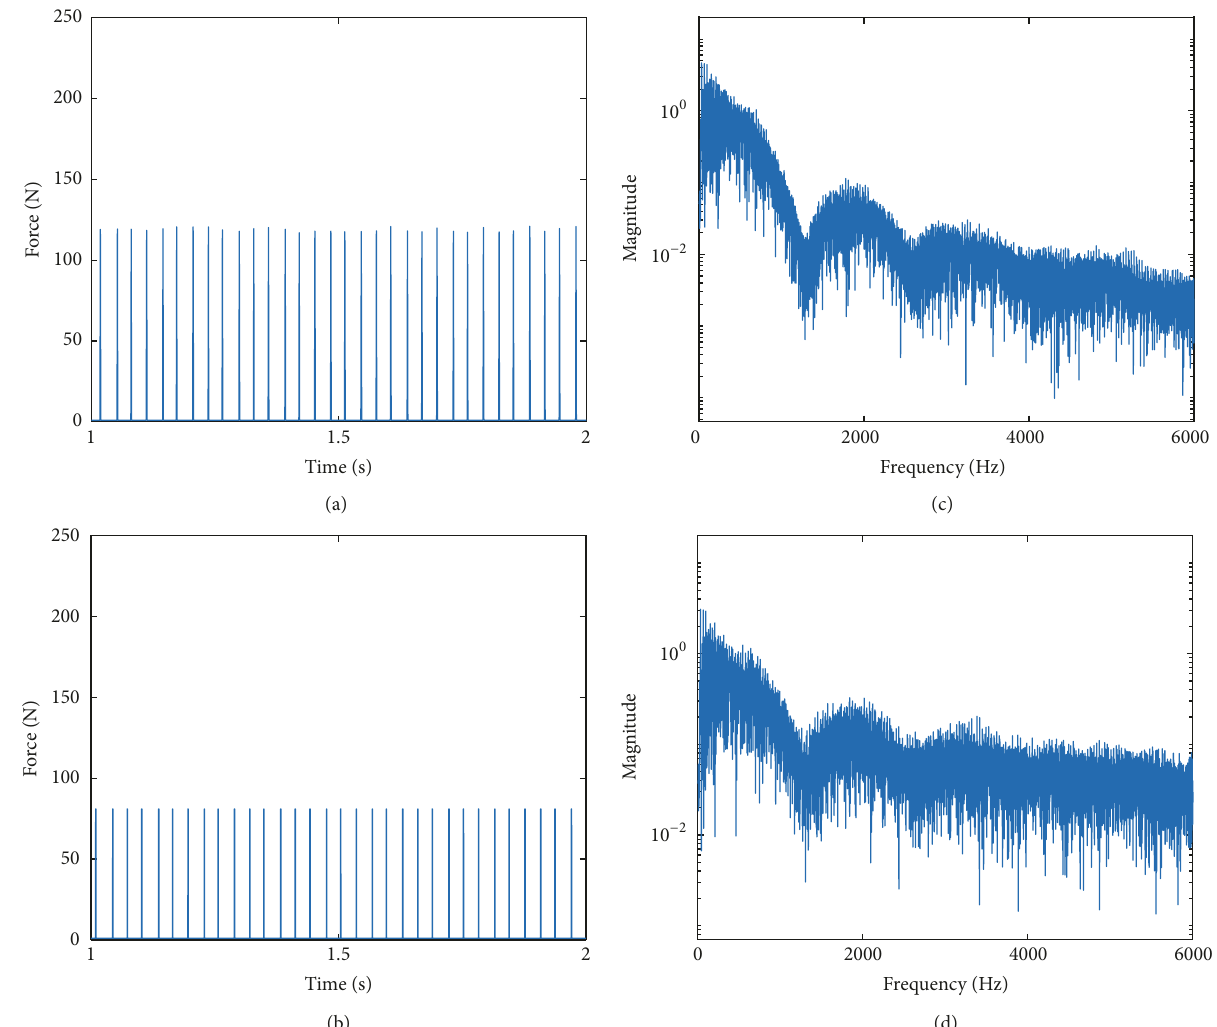
Figure 12: Illustration of the excitation forces to B1 and B2 in the time domain in (a) and (b), and in the frequency domain in (c) and (d),